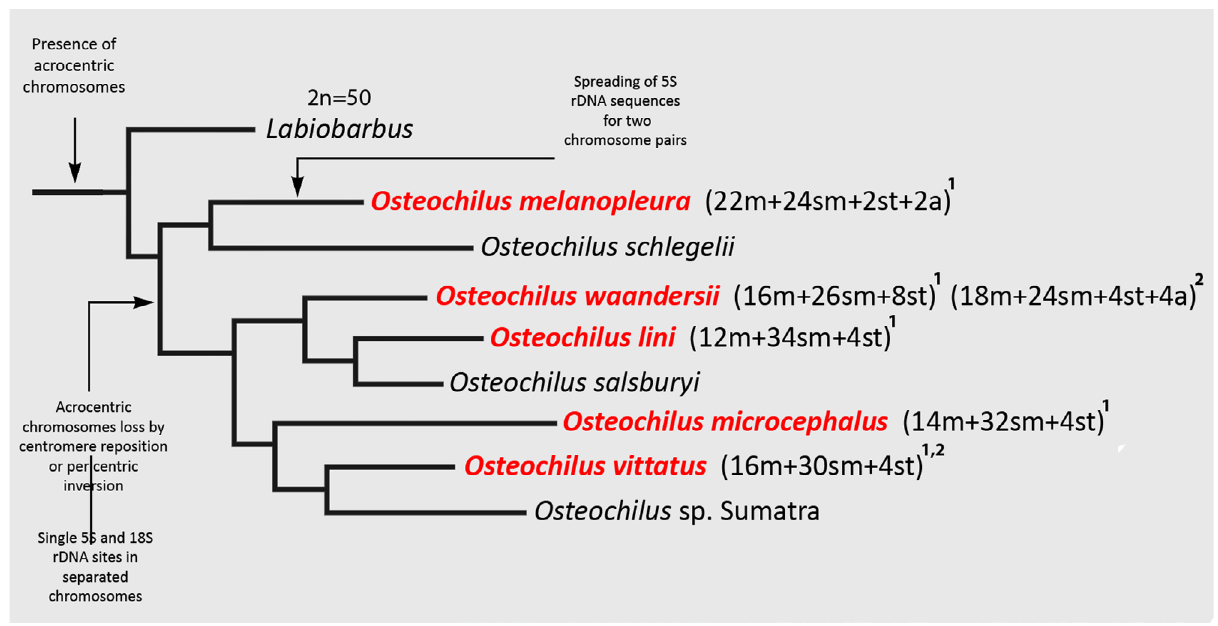
Figure 8 – Adapted phylogenetic tree for the tribe Labeonini, based on the molecular-phylogenetic data generated by Yang et al. (2012) indicating the main chromosomal data obtained in this paper with the superscript 1, and by Magtoon and Arai (1990, 1993) with the superscript